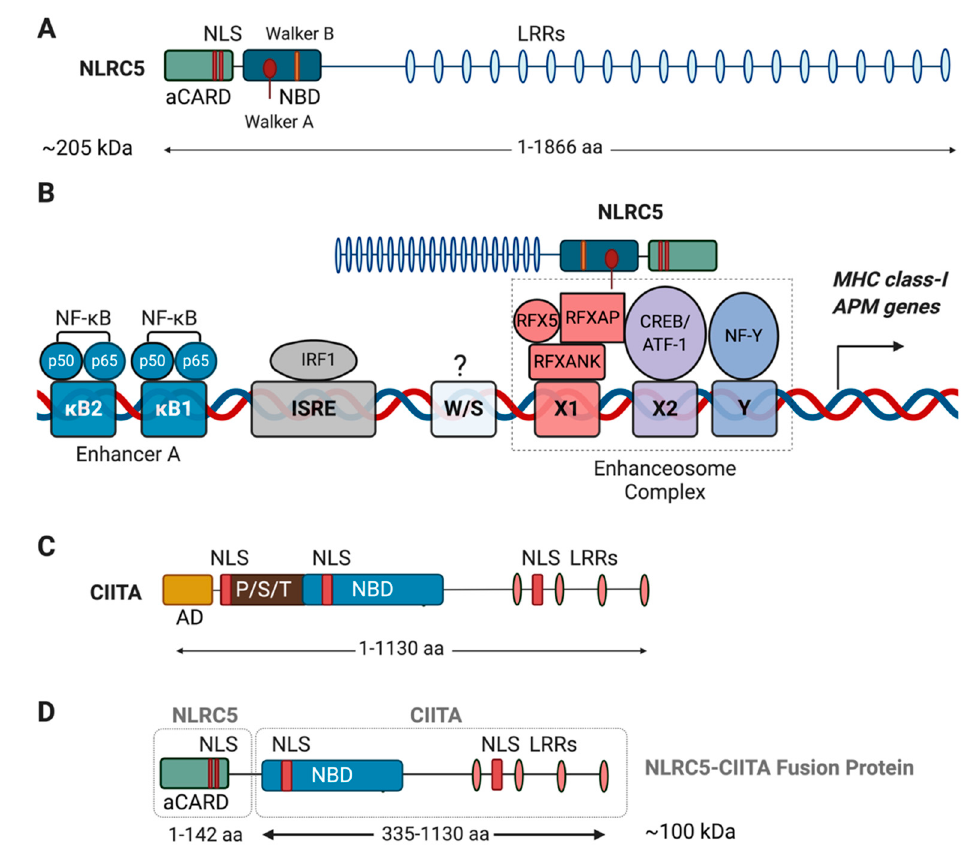
Figure 2. Structure and transactivation functions of NLRC5. ( A ) NLRC5 (1866 aa) displays a tri- partite structure consisting of (i) an atypical CARD (aCARD; 1–139 aa) domain with a helix ex- tending to residue 161 and a bipartite Nuclear Localization Sequence (NLS; 121-122, 132-134 aa),